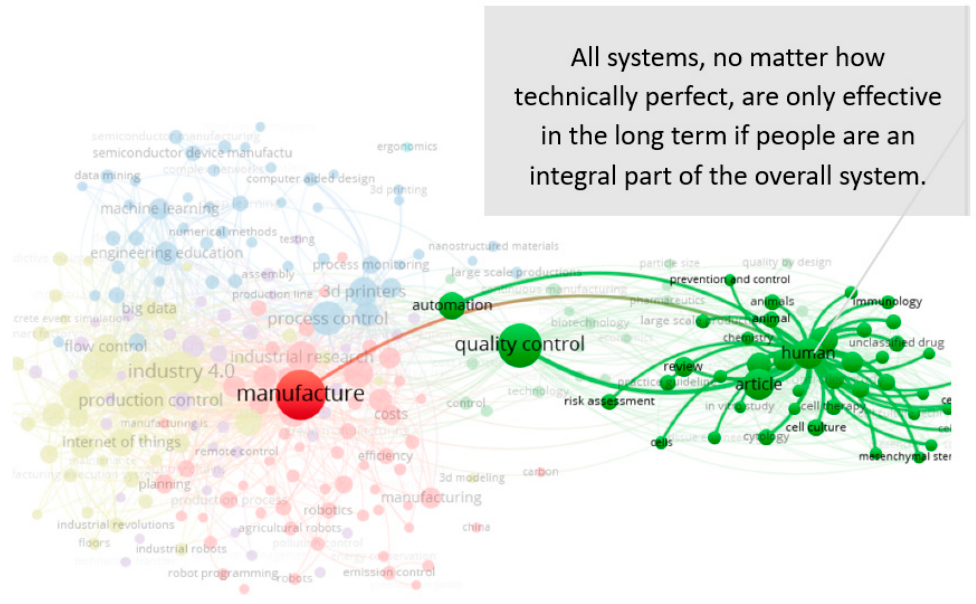
Figure 18. VOSviewer: The HUMAN focus in the context of extended production control.